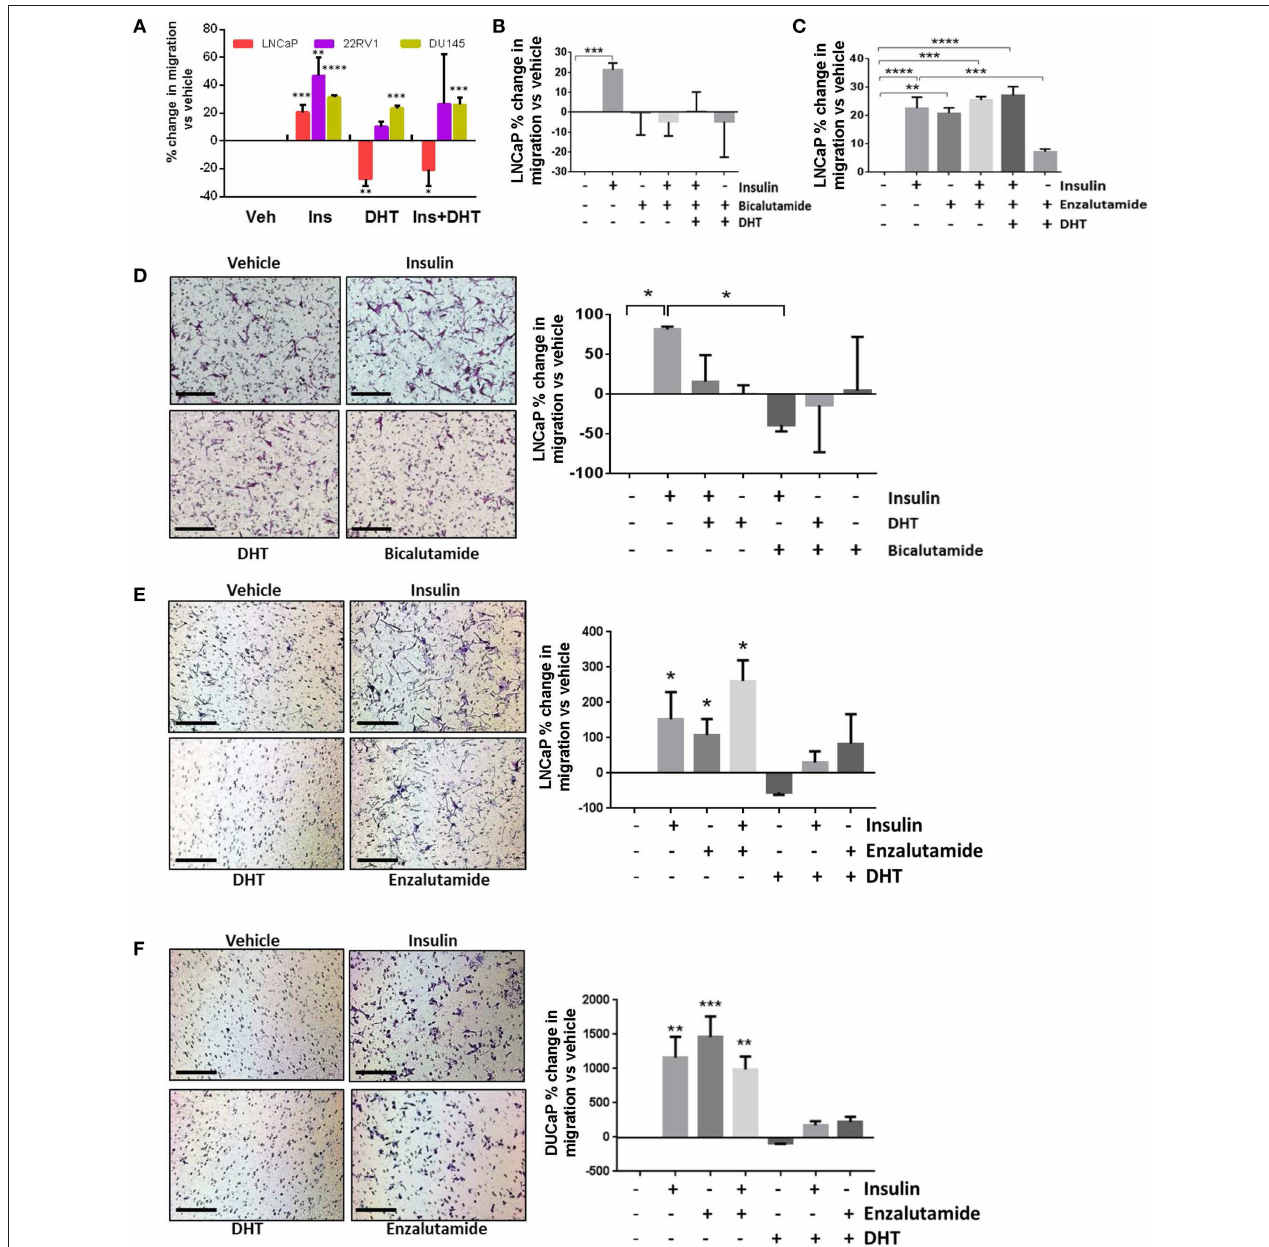
FIGURE 2 | Insulin-induced migration is inhibited by androgens. (A) Wound closure assay showed insulin-induced migration was significantly reduced by 10nM DHT in LNCaP cells. Reduced migration was also observed in 22RV1 cells, but was not statistically significant and DHT had no effect in AR negative DU145 cells. (B) In LNCaP cells, bicalutamide (10 µ M) inhibited migration, however; (C) The addition of enzalutamide (10 µ M) induced migration as potently as insulin. (D) In transwell migration experiments, insulin induced migration, and both DHT and bicalutamide blocked this effect. (E) Enzalutamide, alone and in combination with insulin, significantly increased transwell migration over vehicle. (F) In another AR-sensitive cell, DUCAP, insulin, and enzalutamide both significantly increased transwell migration alone and in combination, blocked by DHT (All graphs n = 3, * p < 0.05, ** p < 0.01, *** p < 0.001, **** p < 0.0001, One-way ANOVA, ± SEM with vehicle as